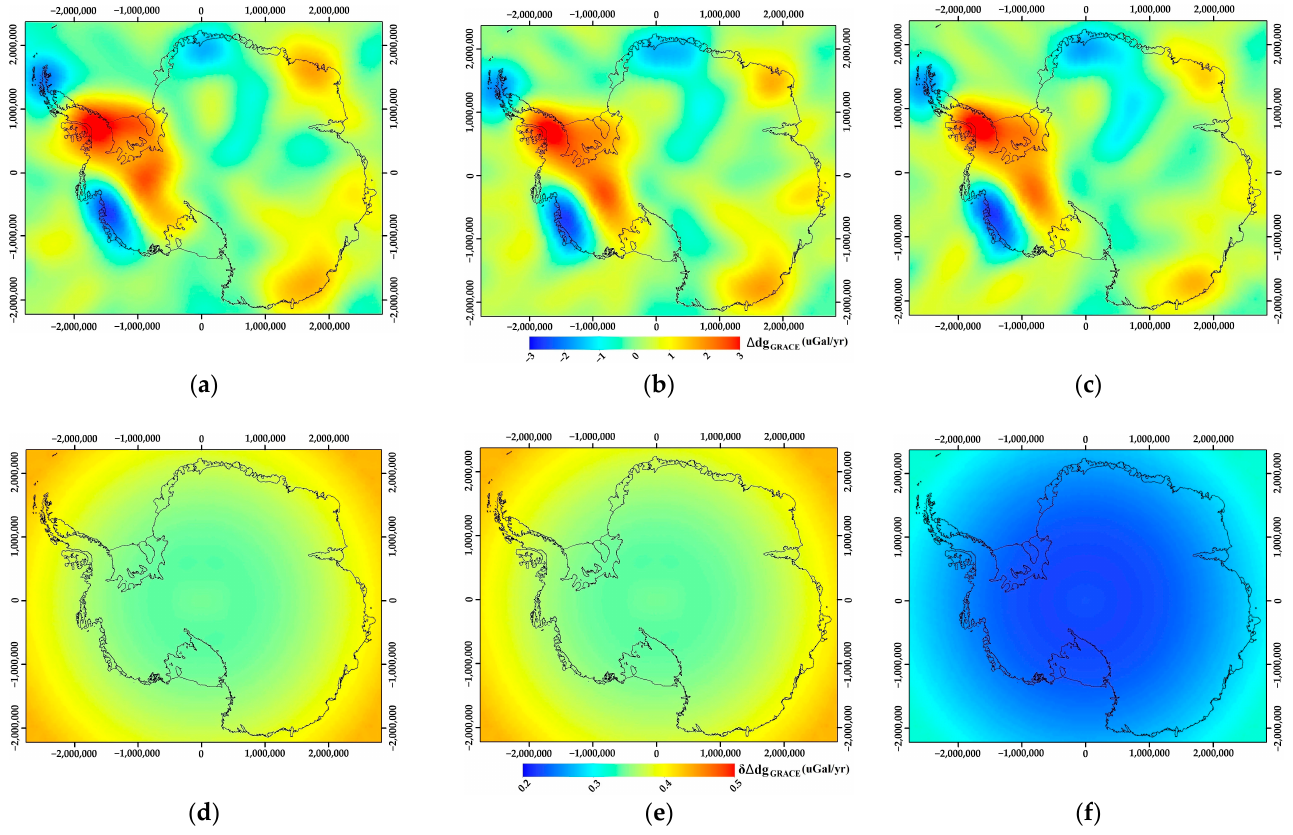
Figure 3. Linear gravity variation trend over AIS estimated from ( a ) CSR ( b ) JPL and ( c ) GFZ, and associated uncertainties ( d – f ). The observation period is consistent with the satellite altimetry simultaneous observation period.